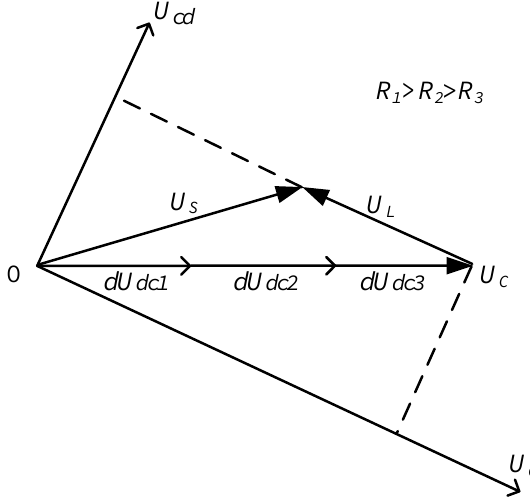
Figure 5. Steady-steady state H-bridge module.